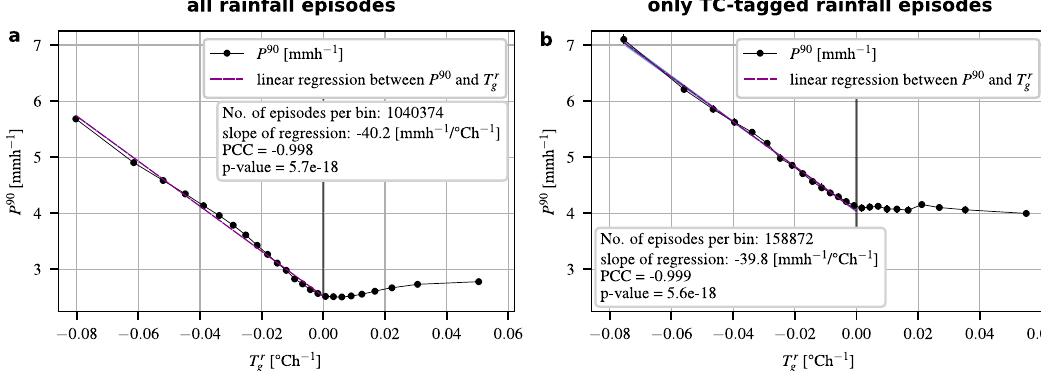
Fig. 4 Scaling between temporal temperature gradients and extreme-rainfall intensities over northern tropical oceans. a Observed scaling between temporal temperature gradients ( T r ) and 90th percentiles of rainfall rates ( P 90 ) for episodes in July – August – September – October (JASO) sampled from all g northern tropical ocean locations (between 0°N and 23°N). Rainfall episodes are split into 25 bins with respect to their preceding temporal temperature gradients ( T r ). The 90th percentile for each bin ( P 90 ) is plotted as a black solid line with markers, the 95% con fi dence intervals are depicted as vertical g black lines, but practically invisible because of their small size. The linear regression through all bins with a negative temporal temperature gradient is depicted as a dashed magenta line. The blue color indicates the 95% con fi dence interval, but is again too small to be visible. b Same as a , but restricted to rainfall episodes associated with TCs listed by the IBTrACS archive 57